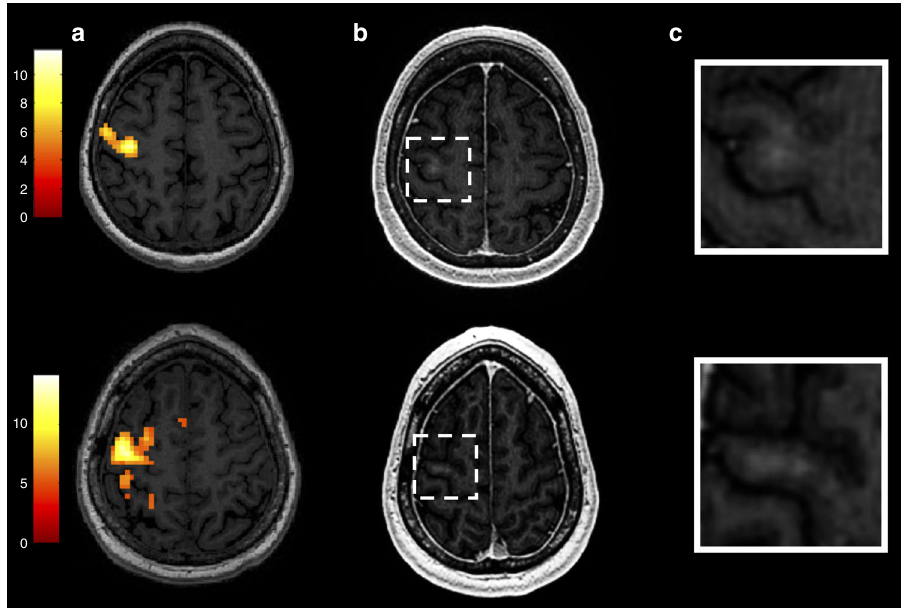
Fig. 2 Feasibility of blood – brain barrier opening using MRgFUS in the hand control region of the right primary motor cortex. a Hand control region mapping using motor-task functional MRI (fMRI). b , c show con fi rmation of successful blood – brain barrier permeabilization in the sonicated primary motor cortex area as demonstrated by new gadolinium enhancement in T1-weighted imaging. Subject two is represented in the top row and subject three in the